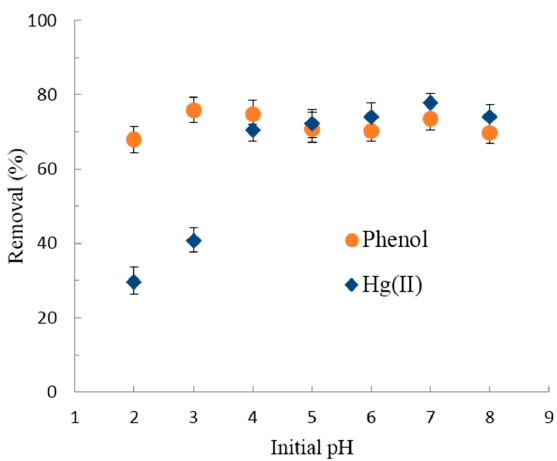
Figure 4. Effect of pH in the removal of Hg(II) and Phenol by functionalized-AC from aqueous solutions (Initial (Hg(II)/phenol) concentration: ~10 mg/L, solid dose: 2.0 g/L, contact time: 12 h).